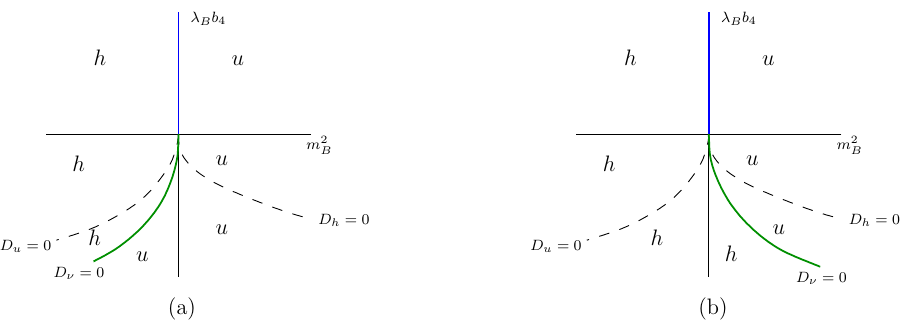
Figure 8 . The phase diagram for (cid:30) 1 < x 6 < (cid:30) 2 . There is a second order phase transition (shown in blue) along the positive (cid:21) B b 4 axis. The (cid:12)rst order phase transition line is the curve (shown in green) between the two dashed curves. The precise location of this phase transition curve varies as we change x 6 . Two possible locations of this curve have been sketched in the two (cid:12)gures above.